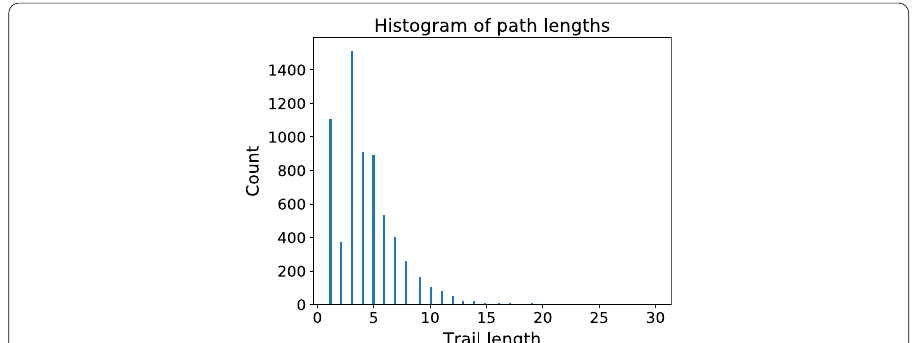
Fig. 3 Histogram of trail lengths. A trail corresponds to the sequence of locations visited by an individual in a day